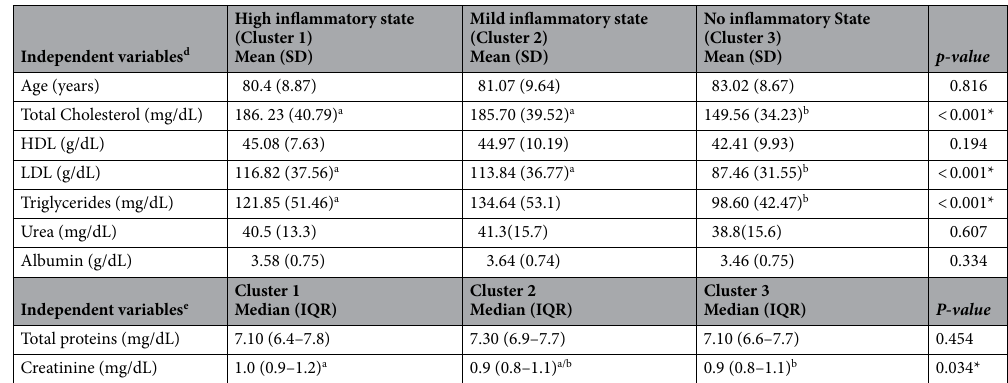
Table 2. Associations between biochemical variables and inflammatory states in institutionalized older people. * p < 0.05. a/b/c Different letters denote a statistically significant difference between the variables. d Data are presented as median and interquartile range considering nonparametric data. e Data are distributed as mean and standard deviation considering parametric